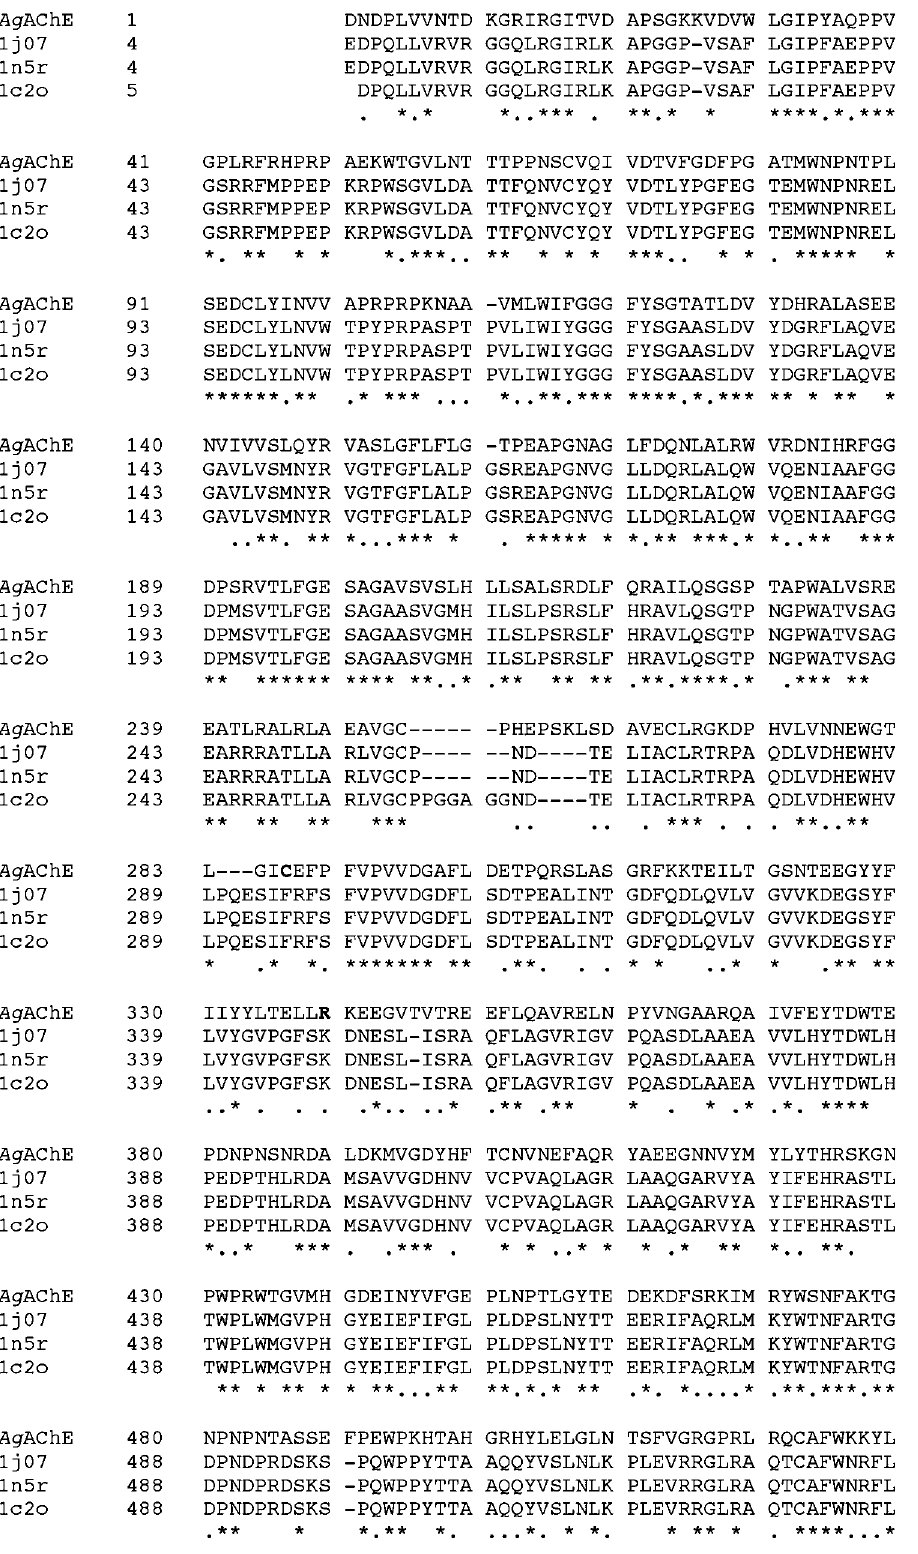
Figure 1. The SwissModel-generated multiple sequence alignments of Anophelesgambiaewith mouse and electric eel acetylcholinesterases GenBank ID of the A. gambiae acetylcholinesterases sequence: BN000066; Protein Data Bank IDs of mouse acetylcholinesterase structures: 1J07 and 1N5R; Protein Data Bank ID of the electric eel acetylcholinesterase structure: 1C2O. The A. gambiae -specific residues (C286 and R339) are colored in red.